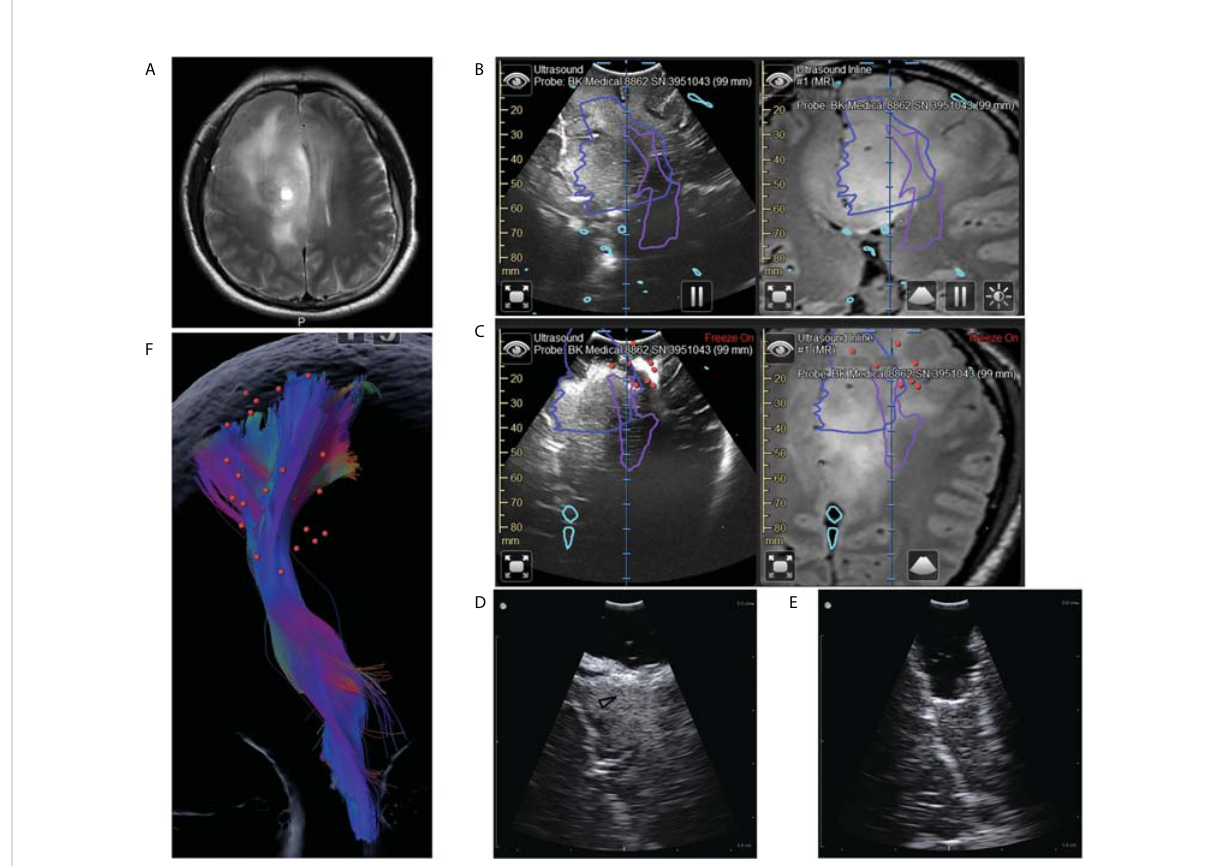
FIGURE 4 Illustrative case 3. (A) On the preoperative MRI images, a tumor could be seen in the right frontal lobe. It was diffuse and lacked de fi ned boundaries. (B) Coplanar MRI and iUS images showed the hyperechoic area was much smaller than the area with abnormal signals on fl are images (blue line). Purple lines represented the pyramidal tract (PT) boundaries revealed by DTI. (C) Intermediate iUS images showing the resection close to the PT. In accordance with iUS, we purposefully increased the spatial and temporal intensity of mapping. The red dots indicate areas where we got positive reactions at the bottom of the resection cavity. The lowest current intensity was 3mA. According to the mapping result, we should stop resection. However, the iUS images revealed a tumor on the medial side of the PT (white arrow). (D, E) The residual tumors (black arrowhead) were then removed with the help of a small bur hole transducer. (F) The spatial relation between the positive mapping sites (red dots) and the pyramidal tract (color streamlines). By integrating iUS with navigation, we were able to position mapping points accurately and